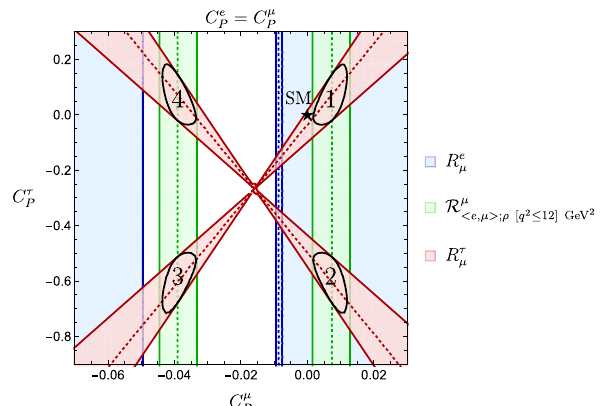
μ – C τ plane utilizing the ratios R e μ , P P under the assumption C e